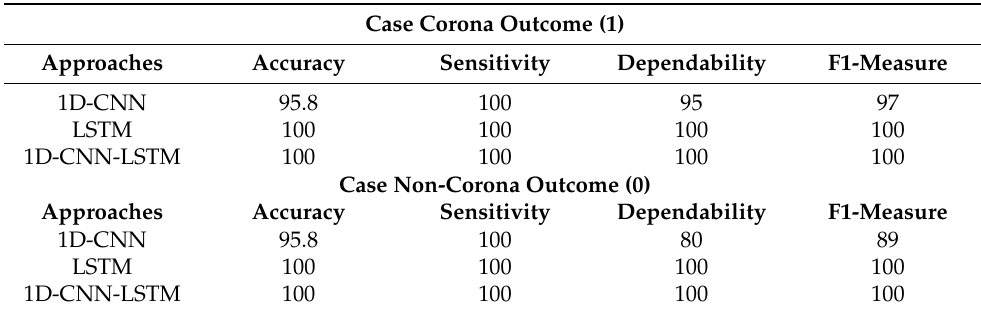
Table 14. The assessment of different metrics in light of the best performance outcomes of DL structures during testing for the frequency domain.